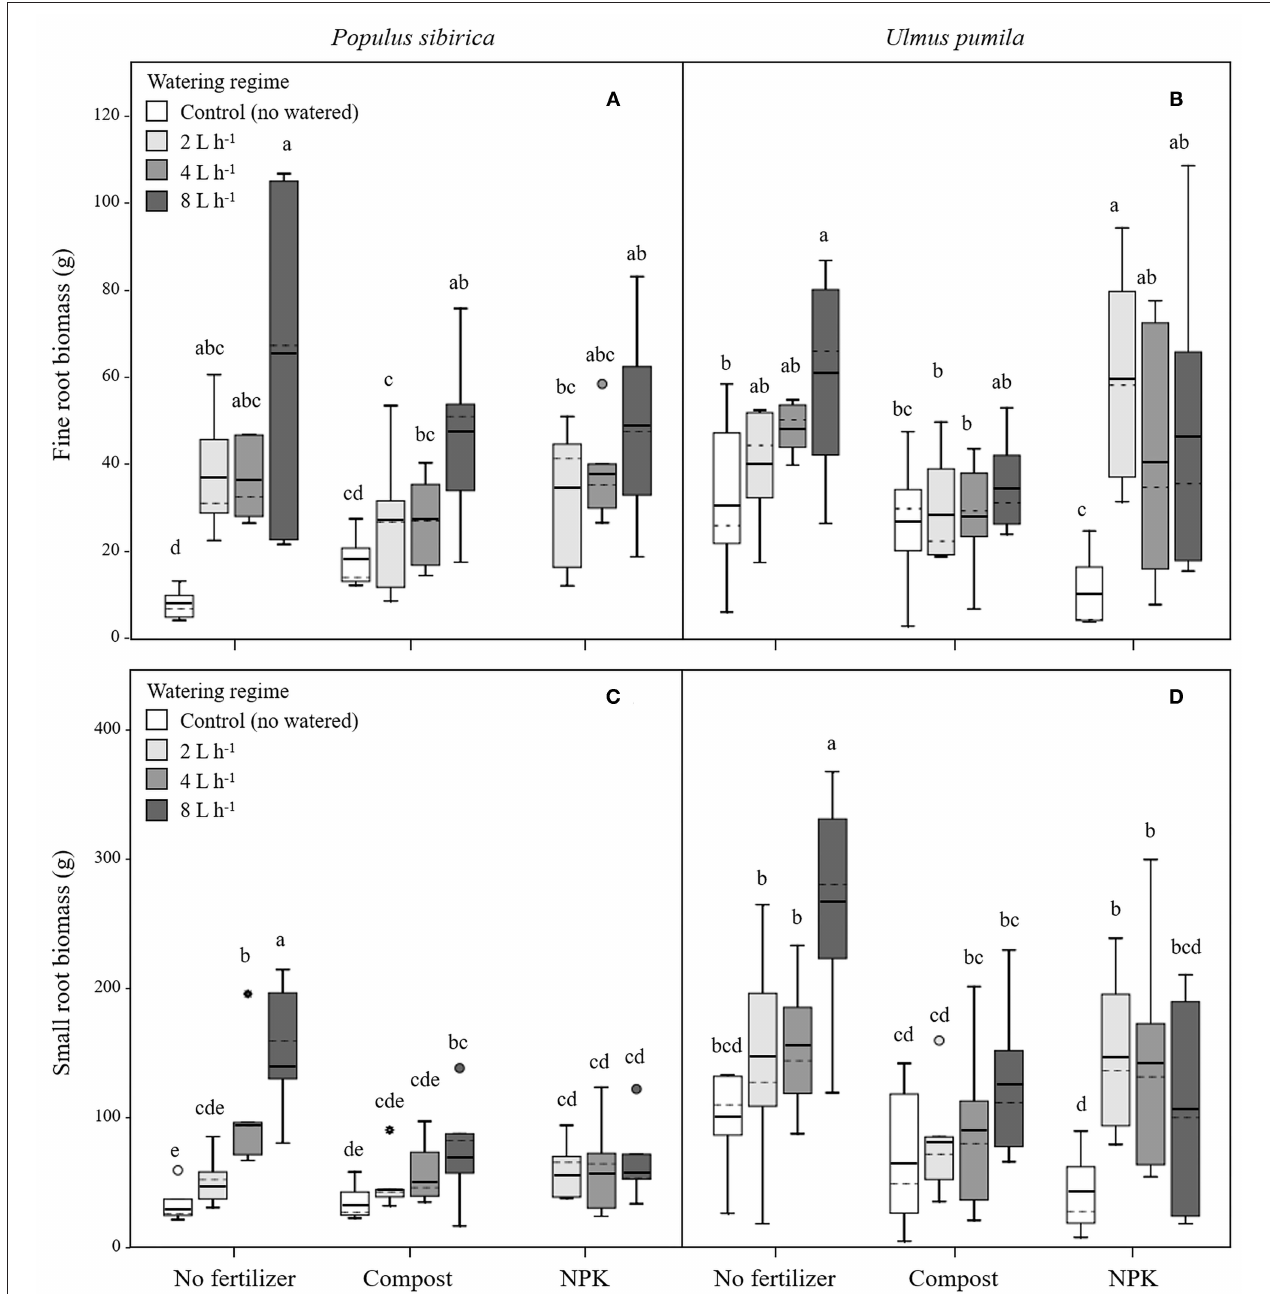
FIGURE 2 | Fine and small root biomass for P. sibirica (A,C) and U. pumila (B,D) for different watering regimes and by different fertilization treatments. Different letters indicate significant differences ( p < 0.05) among watering regimes within each fertilization treatment. Vertical boxes represent ∼ 50% of the observations and lines extending from each box are the upper and lower 25% of the distribution. Within each box, the solid horizontal line is the mean value and the dotted line is the median.